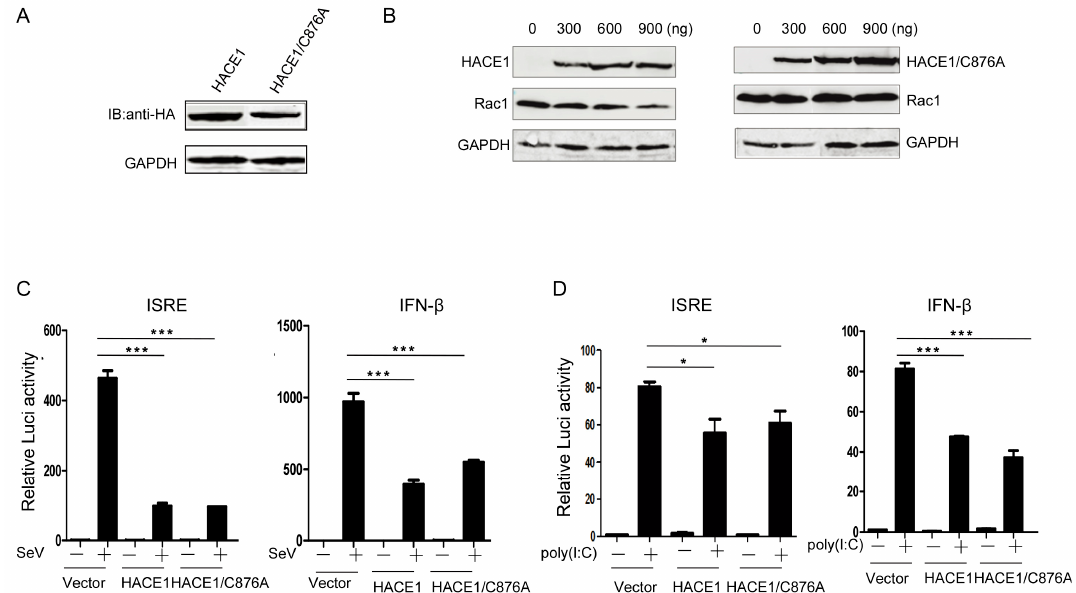
Figure 3. HACE1 inhibited antiviral signaling independently of its ubiquitin E3 ligase activity. ( A ) The expression of sequencing verified that HACE1/C876A was monitored by Western Blot. HACE1/C876A expression vector; ( B ) HACE1/C876A lost the ability to promote the degradation of Rac1. HEK293T cells were coexpressed with Rac1 and increasing amounts of HA-tagged WT HACE1 or HACE1/C876A. Twenty-four hours after transfection, the cells were harvested and detected by Western blot; ( C ) HACE1/C876A still has the ability to inhibit SeV-induced ISRE or IFN- β activation. HEK293T cells were seeded on 24-well plates and were transfected the next day with mock control, HACE1 or HACE1/C876A expressing vector, together with ISRE or IFN- β reporter vector. Twenty-four hours later, cells were infected with SeV or left uninfected for 24 h before luciferase assays were performed; ( D ) HACE1/C876A inhibited ISRE and IFN- β promoter activation by transfected poly (I:C) in HEK293T cells. Data are representative of at least three independent experiments. * p < 0.05; *** p < 0.001.